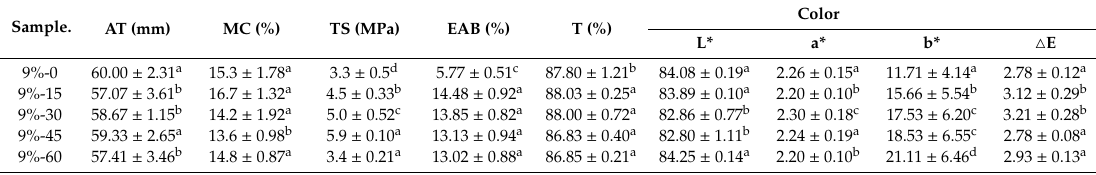
Table 2. Properties of the film prepared using ultrasound treated 9% KS-Col-PVA composite film (AT: average thickness, MC: moisture content, TS: tensile strength, EAB: elongation at break, T: transparency).